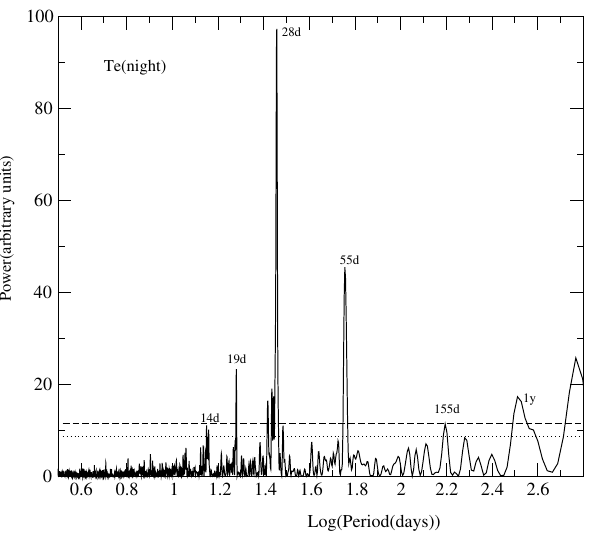
Fig. 4. Spectrum of nighttime electron temperature. The numbers in the figure indicate the corresponding period in days. Confidence levels same as in Fig. 1.